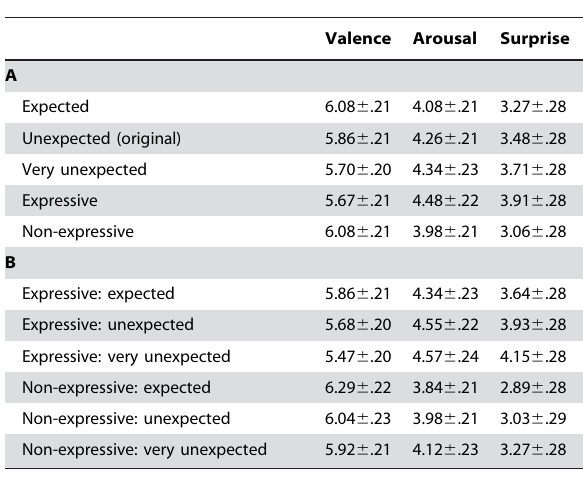
Table 1. Summary of valence-, arousal-, and surprise-ratings (1 corresponded to most unpleasant, least arousing, and